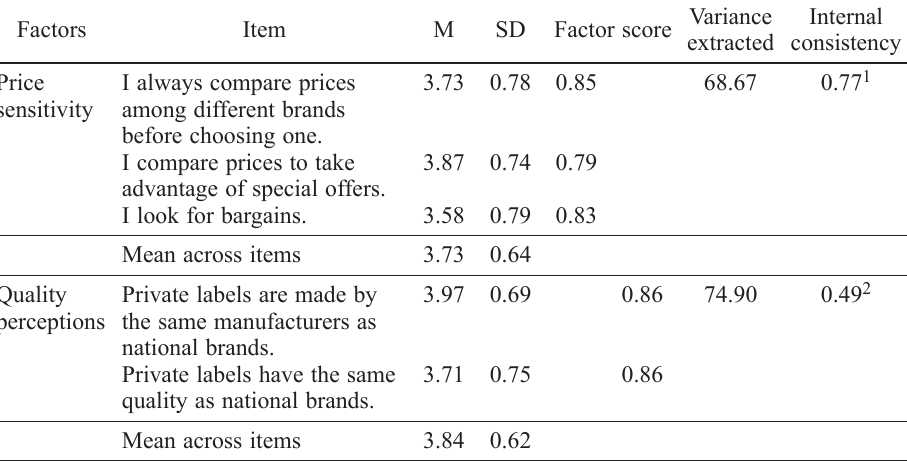
Table 1. Item descriptions and exploratory factor